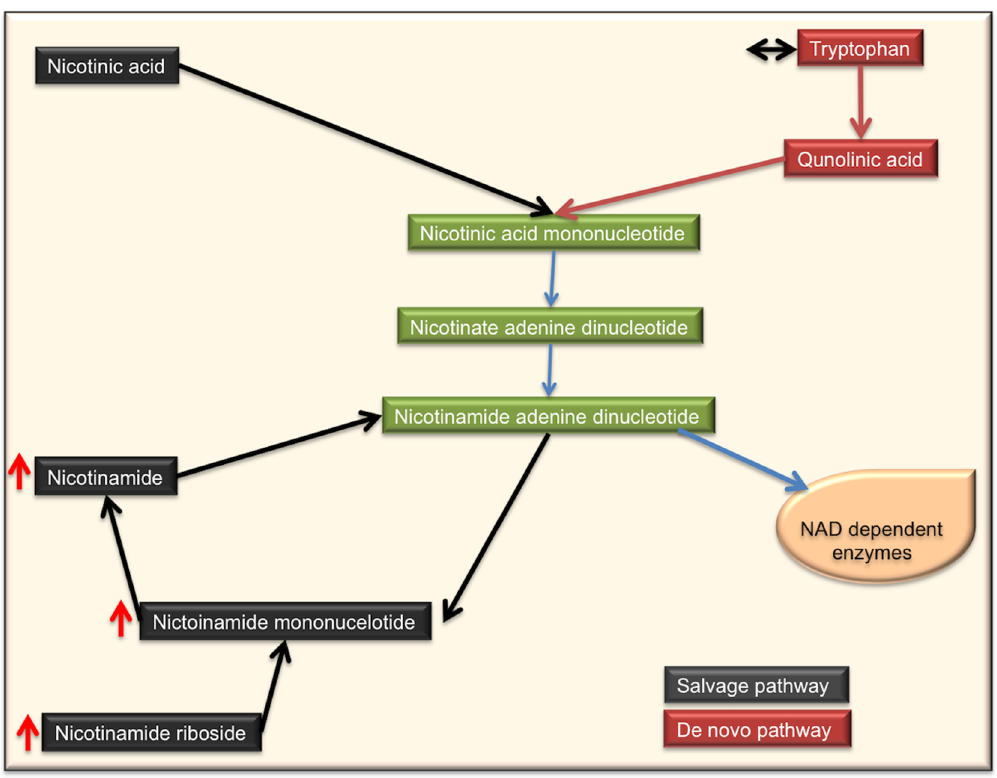
Figure 6. Nicotine metabolism pathway. This schematic presents the de novo and salvage pathways through which the NAD can be generated. Red arrow indicates higher accumulation and black arrow indicates no change.